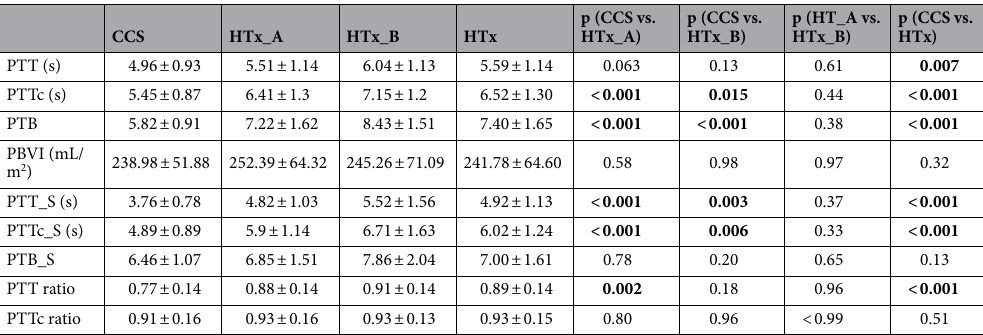
Table 3. Pulmonary circulation biomarkers. Values are presented as mean ± SD unless otherwise indicated. Statistically significant p values are in bold. PTT pulmonary transit time, PTTc Bazett’s formula corrected pulmonary transit time, PTB pulmonary transit beats, PBVI pulmonary blood volume index, PTT_S stress pulmonary transit time, PTTc_S Bazett’s formula stress pulmonary transit time, PTB_S stress pulmonary transit beats, PTT ratio pulmonary transition time ratio, PTTc ratio Bazett’s formula corrected pulmonary transition time ratio, HTx heart transplant group, HTx_A heart transplant without diastolic dysfunction subgroup, HTx_B heart transplant with diastolic dysfunction